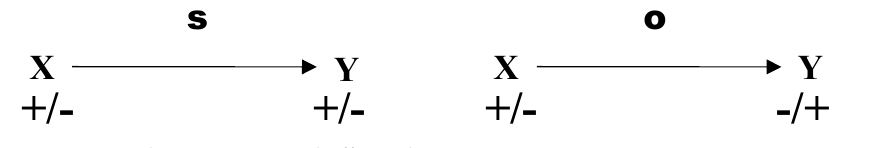
Figure A1. The two cause-and-effect relations There is no limit to the number of connected variables forming a causal chain .